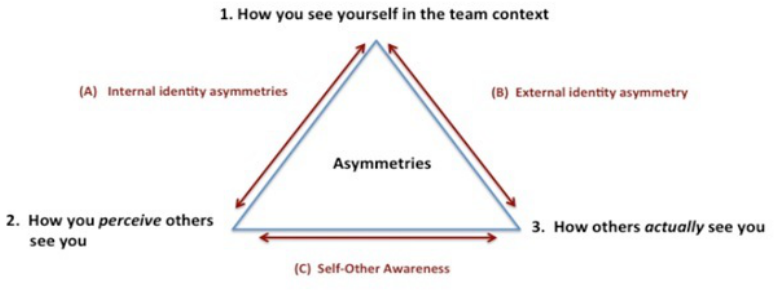
Figure 1: Internal identity asymmetries(Meister et al.,